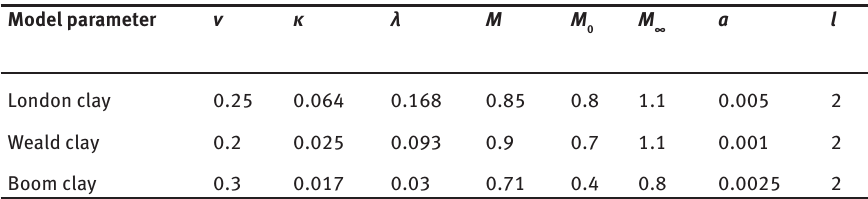
Figure 5: Simulation of undrained compression of London clay for normally consolidated and overconsolidated Table 3: MCC and SCSM parameters for different clays.